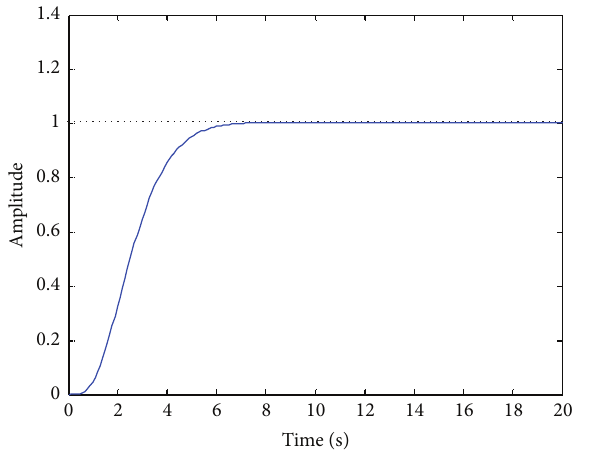
Figure 12: Airplane real trajectory.